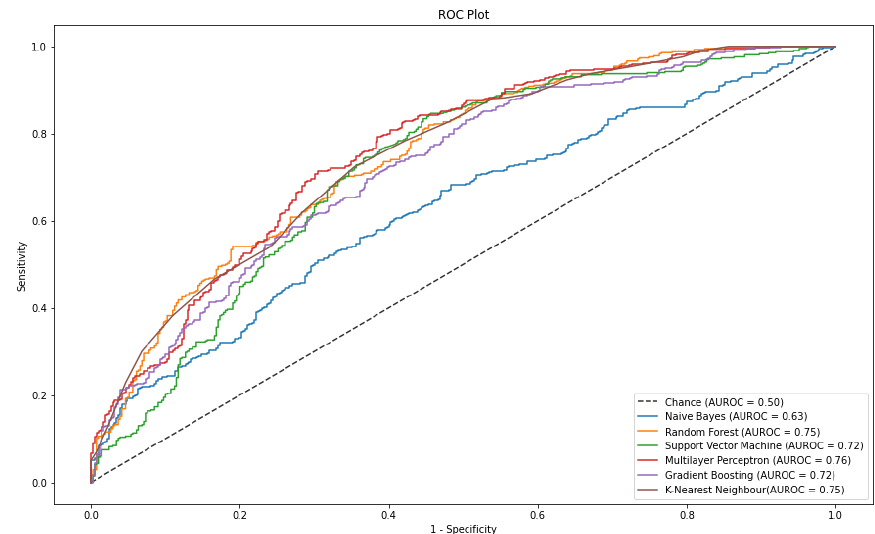
Figure 7. ROC curve plot of each classification model tested on modified-dataset. The AUROC scores were achieved by the models during stress prediction of the test dataset from the modified-dataset.